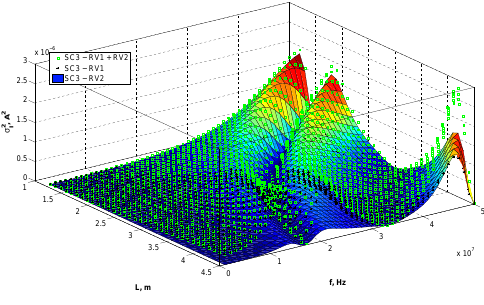
Figure 9: σ 2 from RV 1 and/or RV 2 I